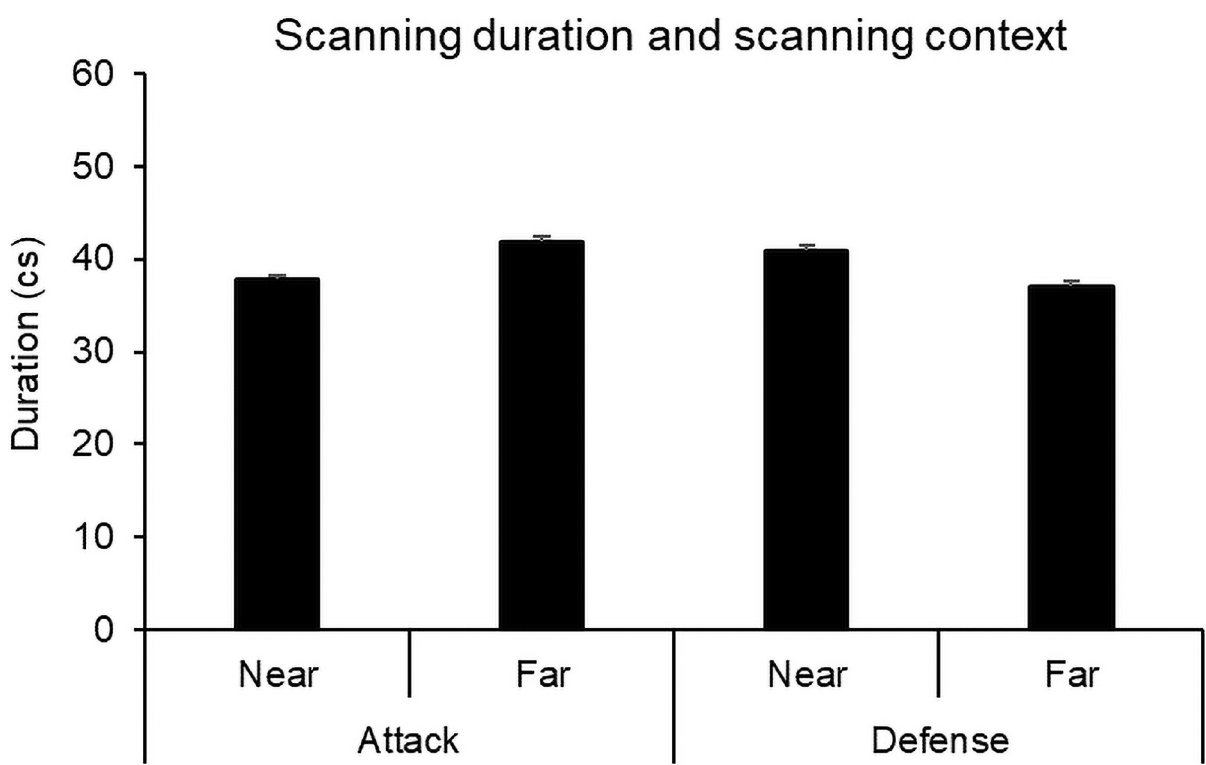
Fig 5. Means and standard errors of scanning duration as a function of playing phase (attack, defense) and player-to-ball distance (near, far).